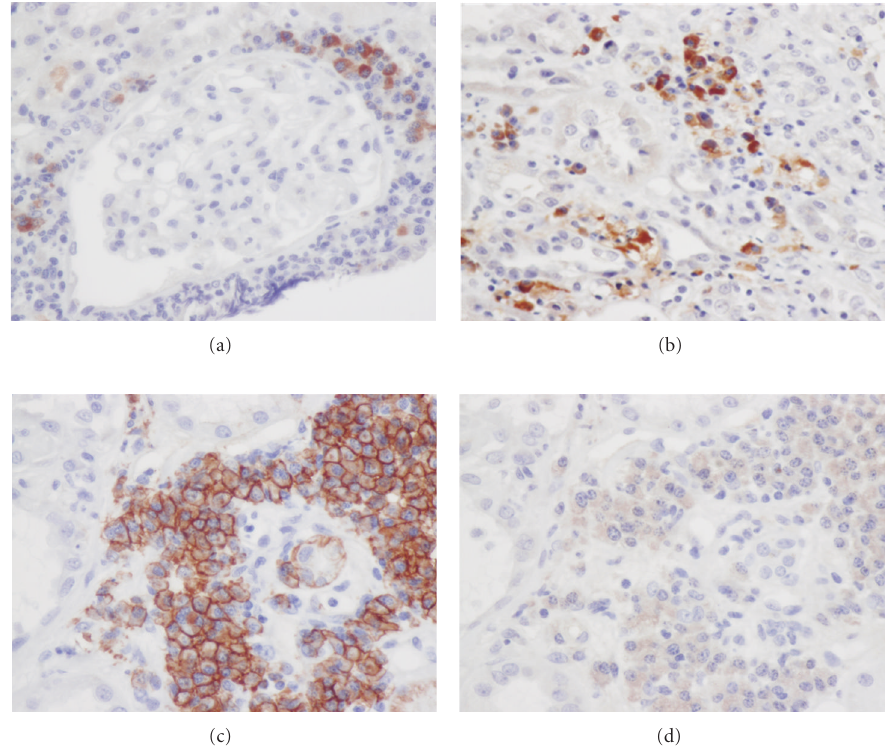
Figure 4: Anti-neutrophil cytoplasmic antibodies (ANCA) associated vasculitis. (a) IgG4+ plasma cells surround a glomerulus (IgG4 immunostaining × 400). (b) Accumulation of many IgG4+ plasma cells is seen in the interstitium (IgG4 immunostaining × 400). (c) Many CD138+ cells are seen in the interstitium (CD138 immunostaining × 400). (d) These plasma cells are IgG4 negative (IgG4 immunostaining